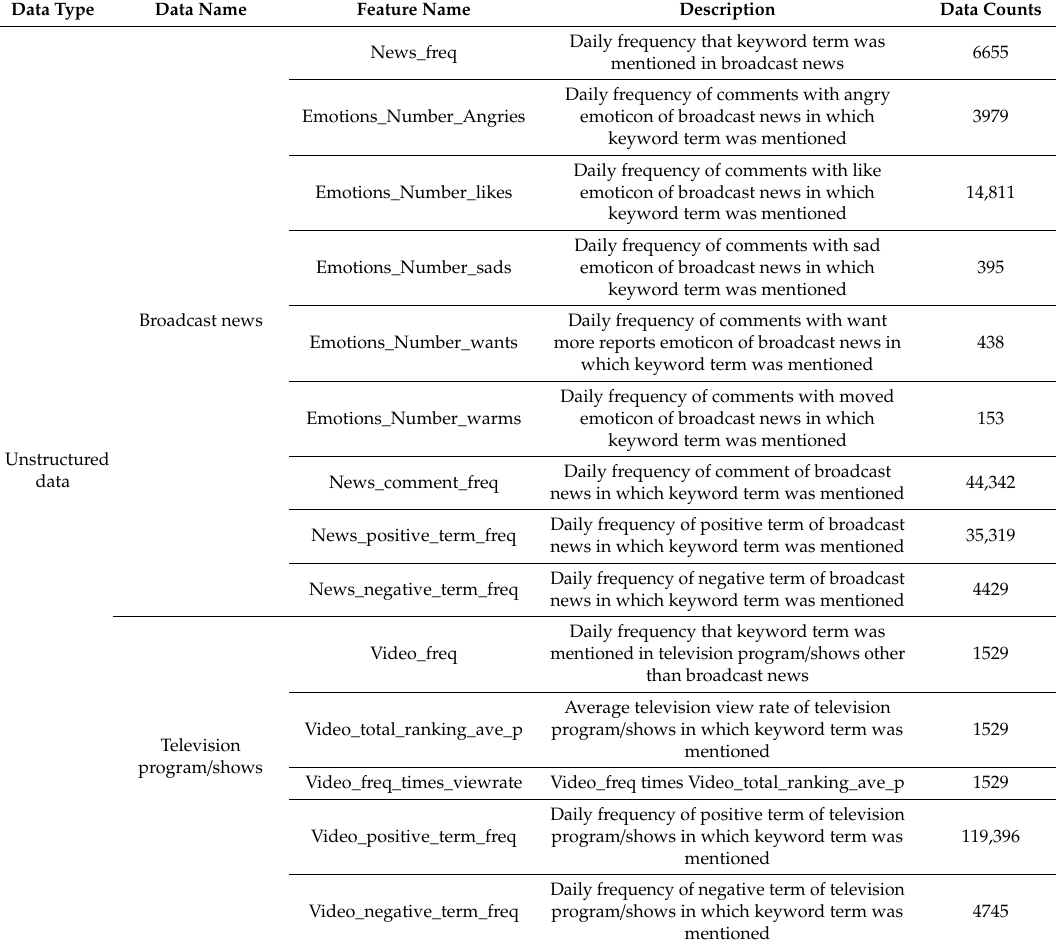
Table 2. List of features of unstructured data used in the